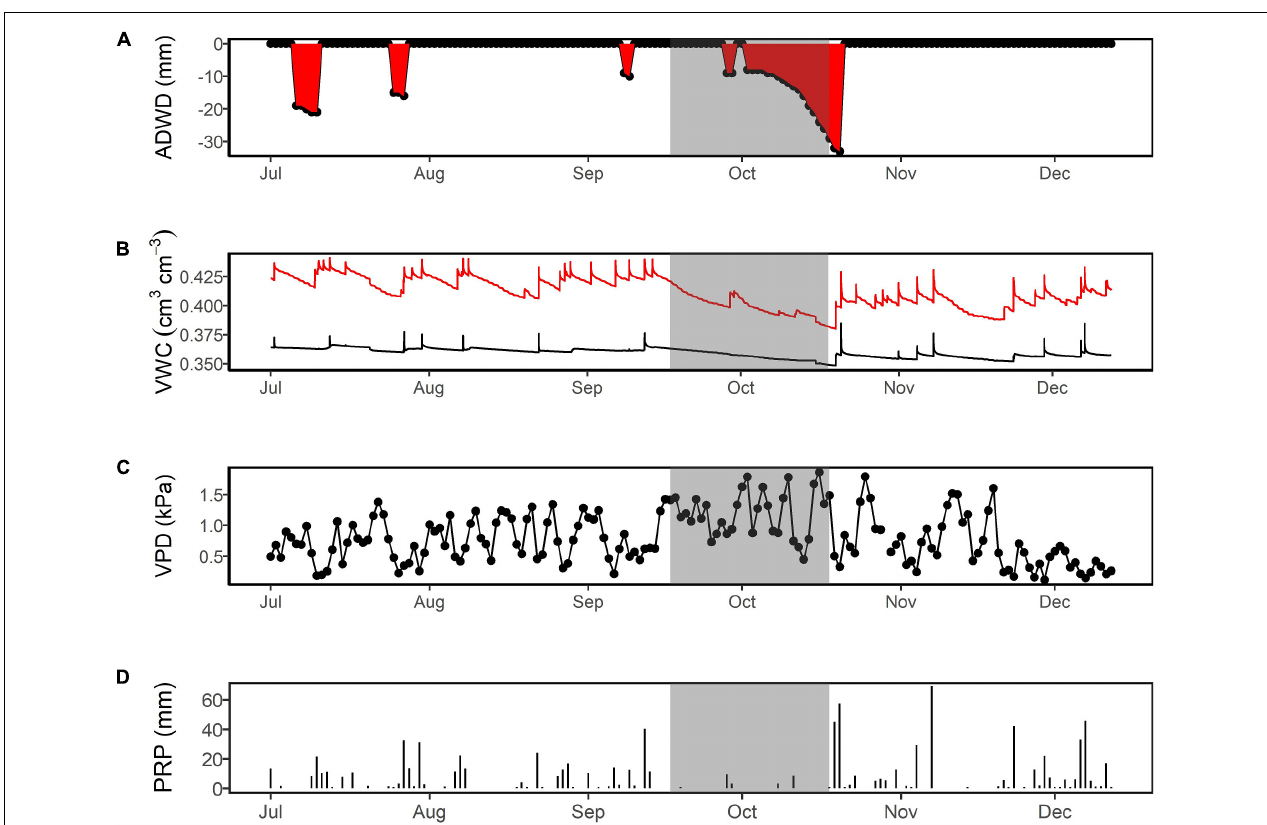
FIGURE 1 | Characteristics of the 2018 dry season at ZF2 in the central Amazon (typically, July to December). The highlighted gray period is indicated by four metrics: (A) the accumulated daily water deficit (ADWD), which is used to describe the duration and intensity of the drought; (B) volumetric water content (VWC) at 15 cm (red line) and 75 cm (black line) depth, which indicates rates of water extraction; (C) vapor pressure deficit (VPD) as an explanatory variable of evaporative demand; (D) and precipitation, as a variable governing the volume of water entering the